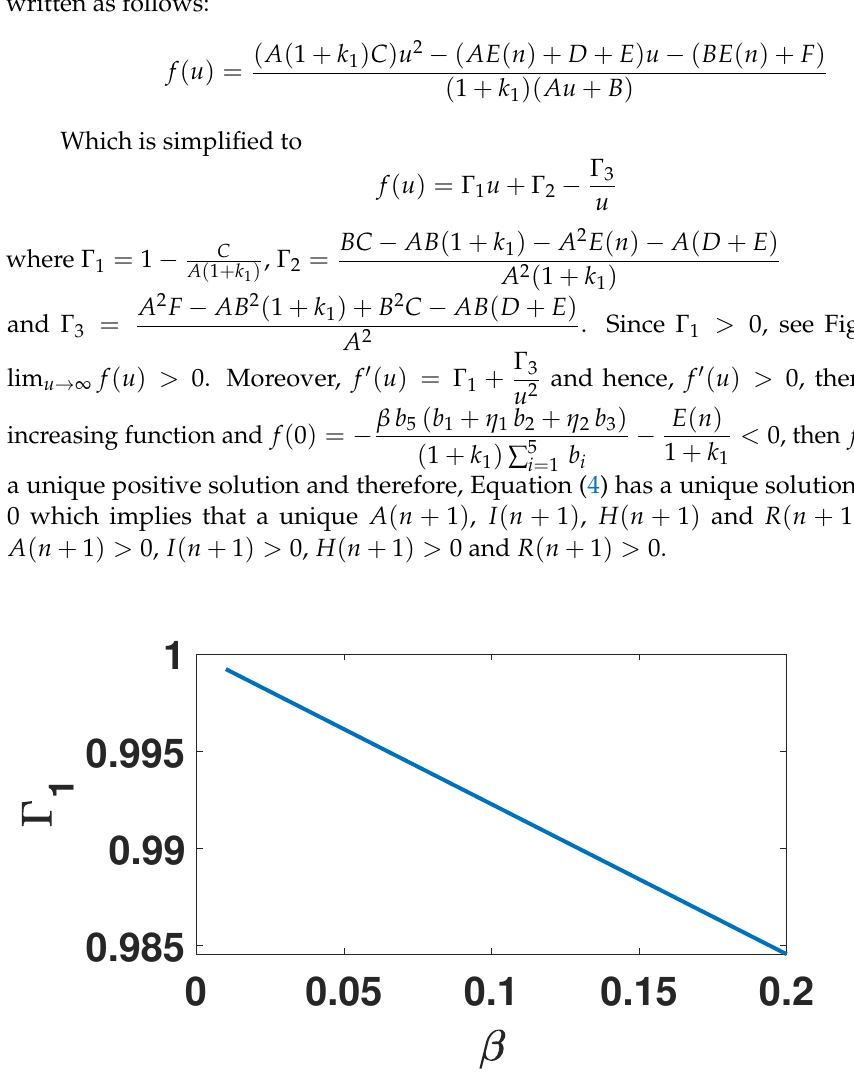
Figure 2. The plot of the the cofactor Γ 1 as a function of β